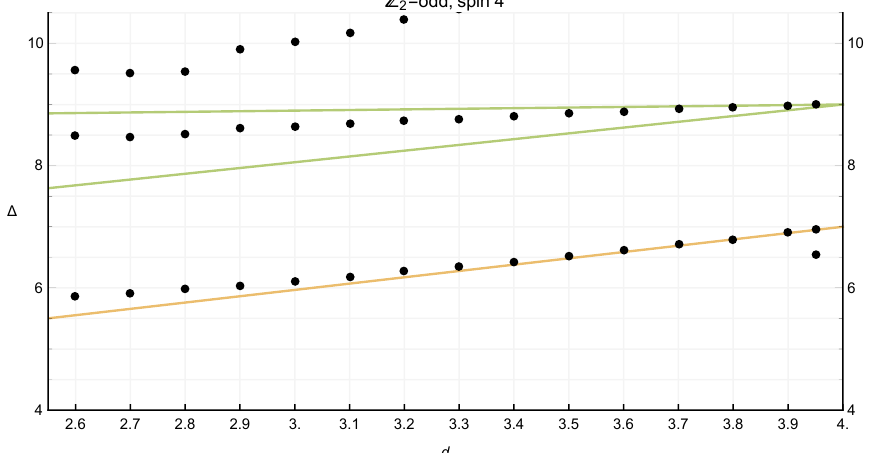
Figure 15 . Z 2 -odd operators of spin 4.